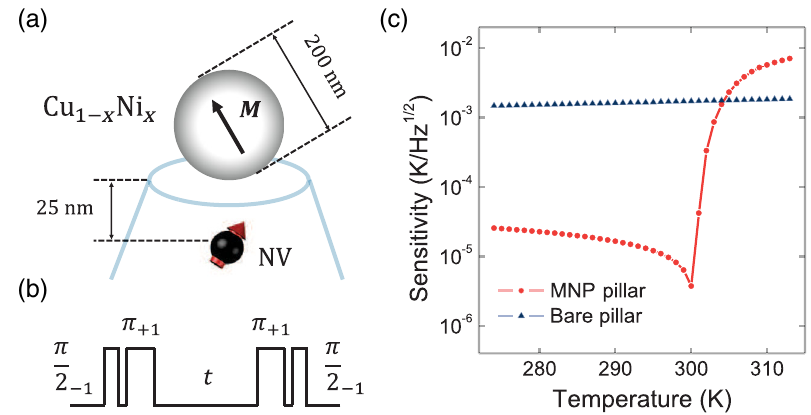
FIG. 6. Theoretical sensitivity of a hybrid nanothermometer composed of a MNP and a single NV center in a diamond nanopillar. The nanostructure-enhanced fluorescence collection efficiency and long coherence times of single NV centers in diamond nanopillars greatly improve the temperature sensitivity. (a) Schematic of the hybrid sensor that contains a MNP on the top of a diamond nanopillar with a single NV center 25 nm below the surface. (b) Microwave control pulse sequence for Ramsey interference between the m S ¼ − 1 and m S ¼ þ 1 states. The π /2 pulses and π pulses are applied on the m S ¼ 0 ↔ m S ¼ − 1 and m S ¼ 0 ↔ m S ¼ þ 1 transitions, respectively. (c) Sensitivity versus temperature. The red circles are for the hybrid sensor and the blue triangles are for a bare NV center sensor under the pulse control scheme in Refs. [20 – 22]. The NV spin coherence times are assumed as T (cid:3) 2 ≈ 1 . 9 μ s (used for the hybrid sensor) and T 2 ≈ 85 μ s [22] (used for the bare NV center sensor), and the photon count rate is L ≈ 1 . 7 Mps